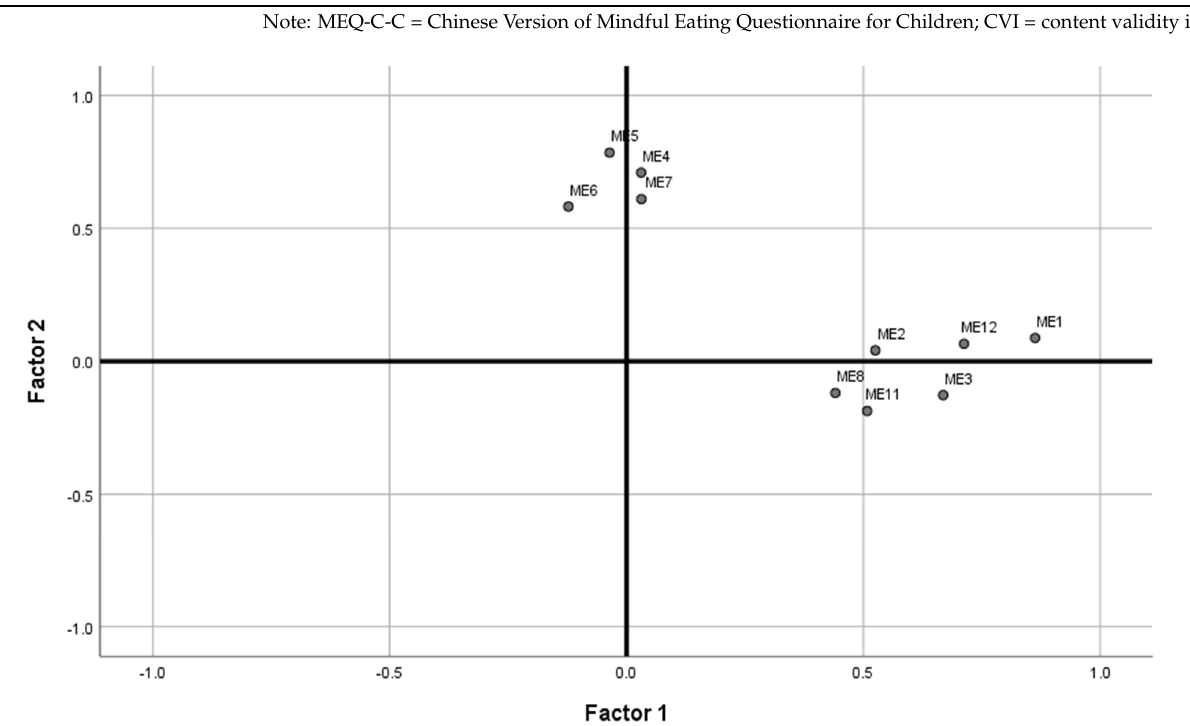
Table A3. Internal consistency reliability test. Item